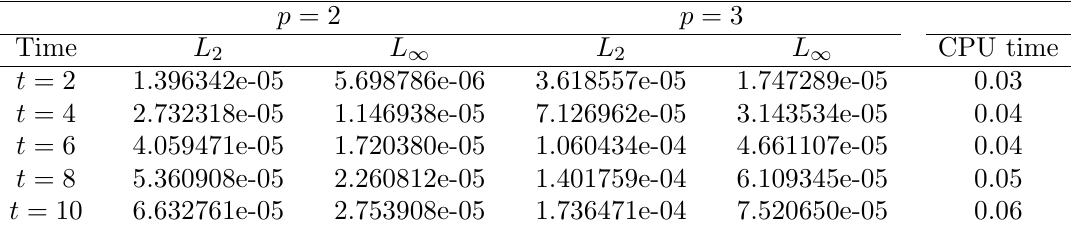
Table 3. Error norms and CPU times for N = 100, c = 0 . 1, ∆ t = 0 . 05, x 0 = 40 on 0 ≤ x ≤ 100 at different times.